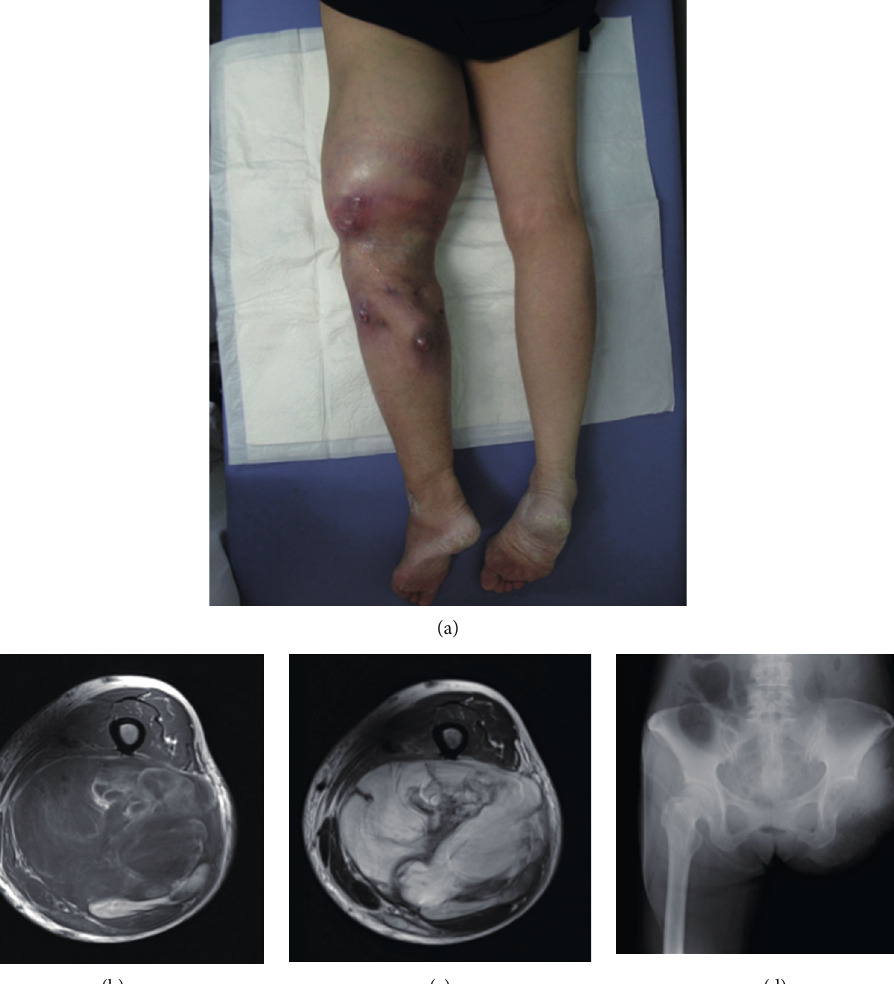
Figure 2: Tumor at the moment of revisiting and hip disarticulation for tumor excision. Tumor in (a) macroscopic image, (b) T1-weighted, and (c) T2-weighted MRI. (d) Plain radiograph after left hip